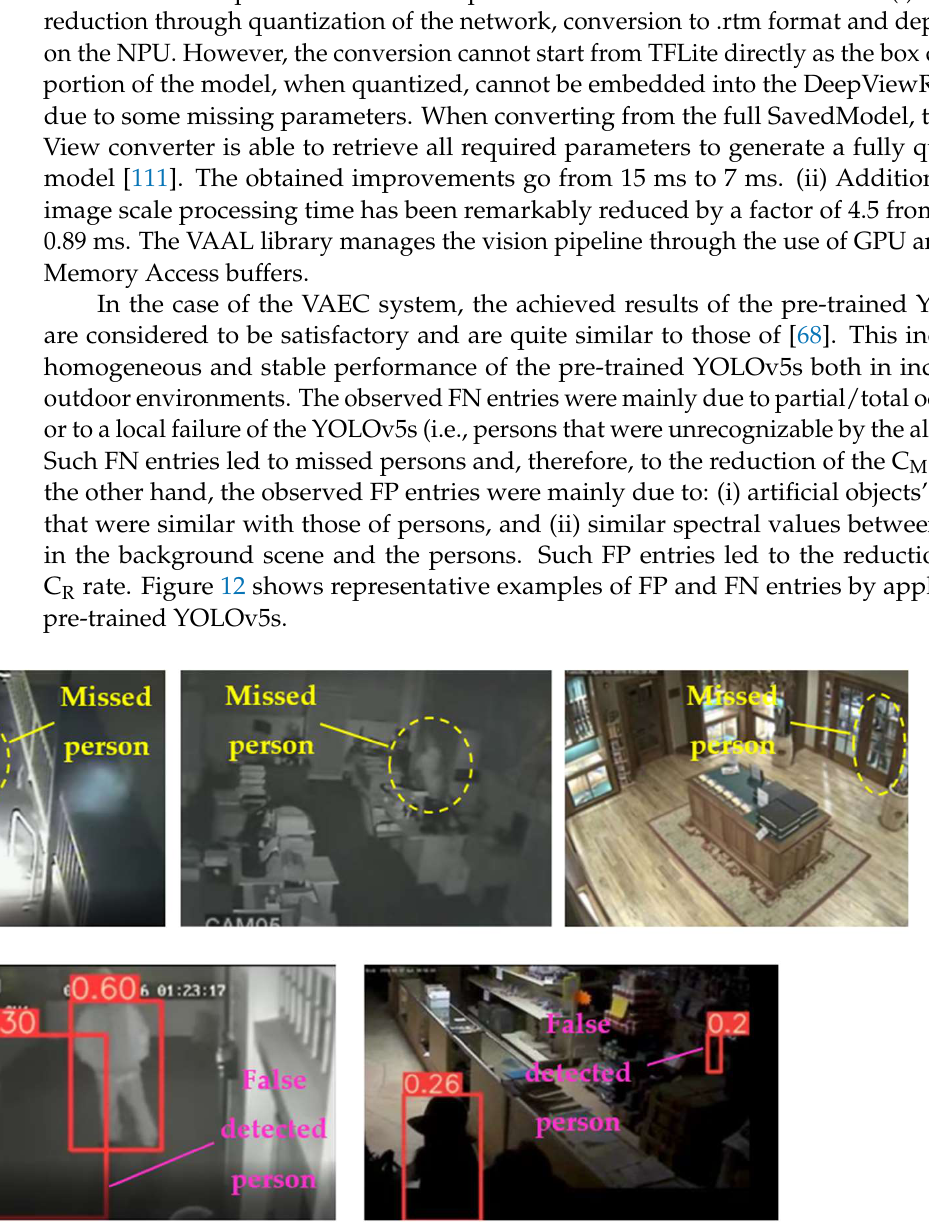
Figure 12. Observed FN entries (yellow ellipse with dashed line) and FP entries (magenta indications) during the person detection process applying the pre-trained YOLOv5s.